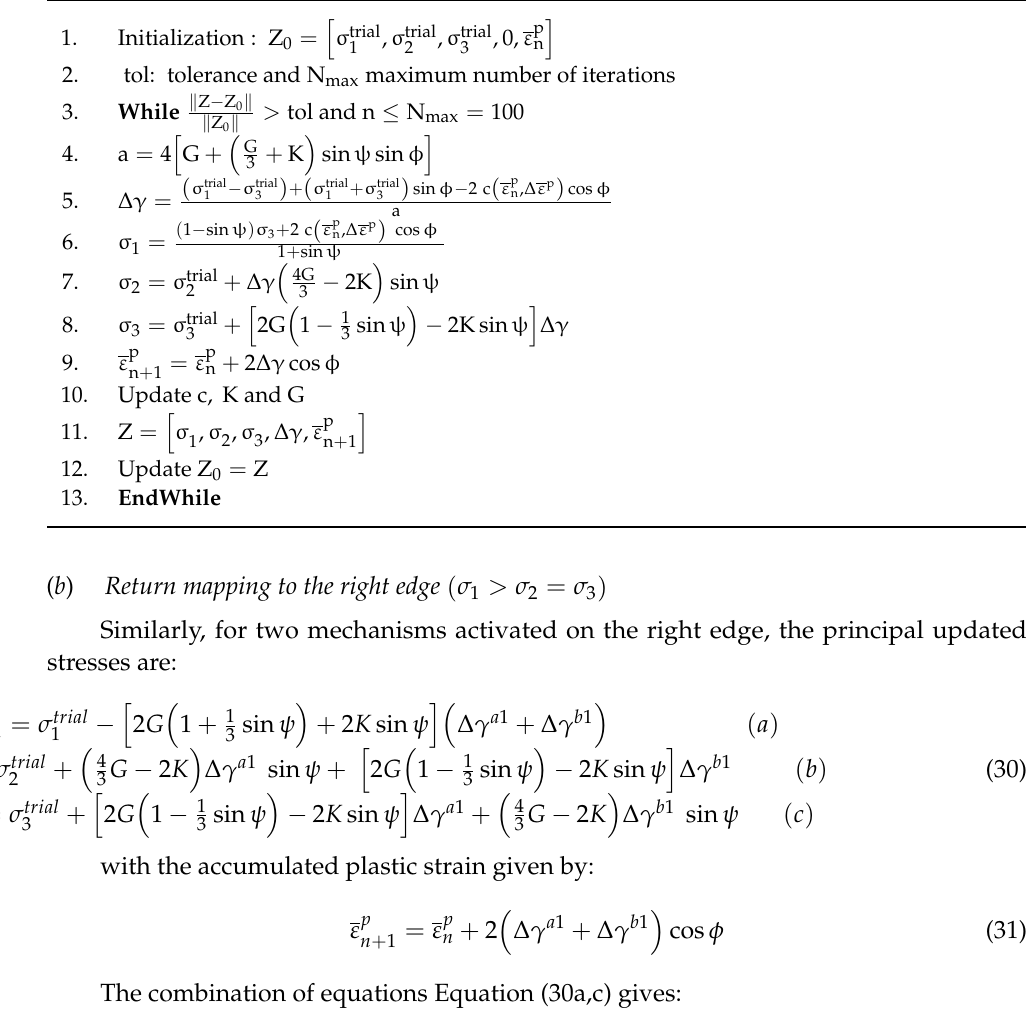
Algorithm 3 : Fixed point algorithm applied to the main plane